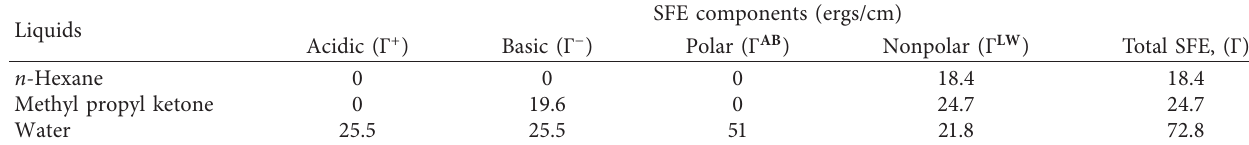
Table 3: SFE components of materials to calculate the same components for aggregates.